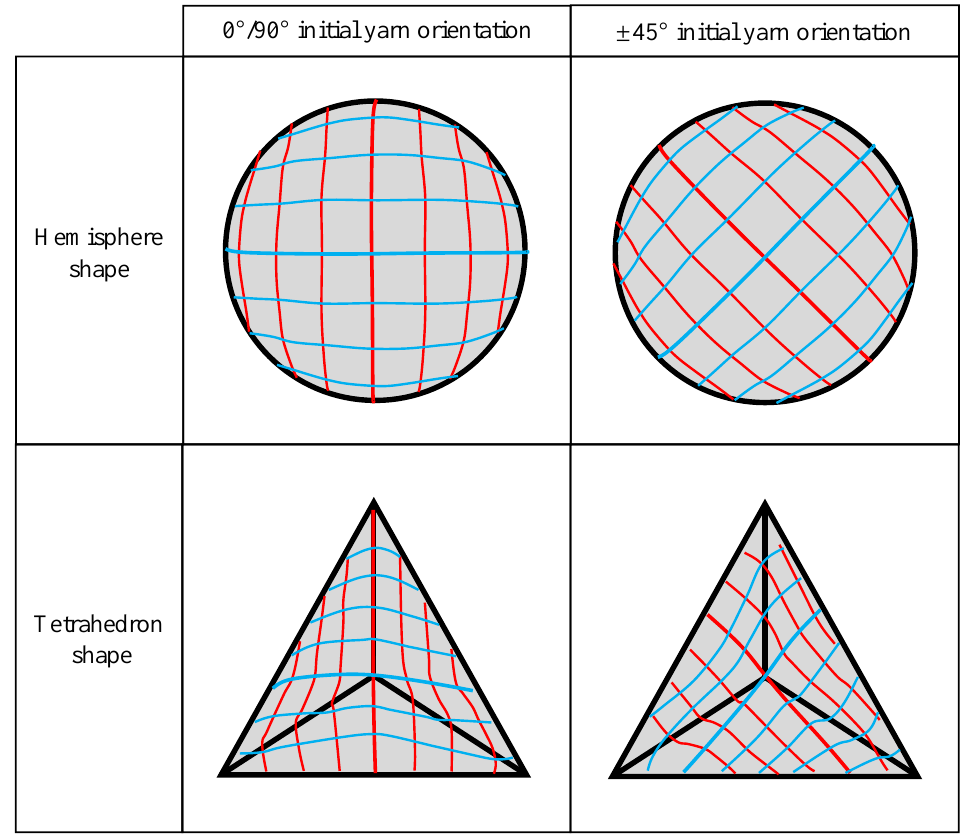
Figure 11. Yarn orientations after preforming for the hemispherical and tetrahedral preforms. Red lines for weft yarns; blue lines for warp yarns.